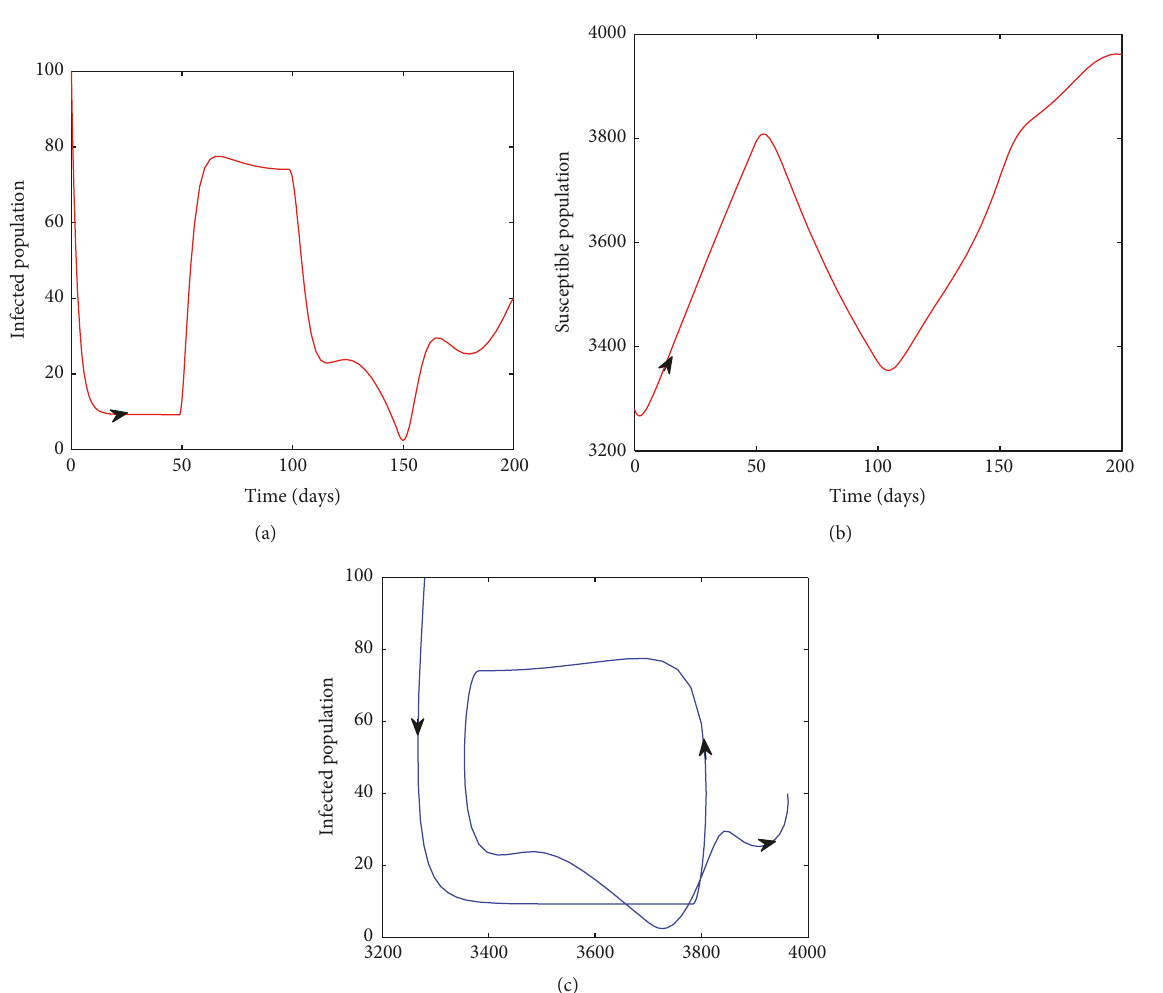
Figure 4: Simulation of model (1) for 𝜏 2 = 0 and 𝜏 1 > 0 , with initial variable values: (𝑆(0),𝑉(0),𝐸(0),𝐶(0),𝐼(0)) = (3280,30,10,10, 100) . The rest of the parameters are as in Table